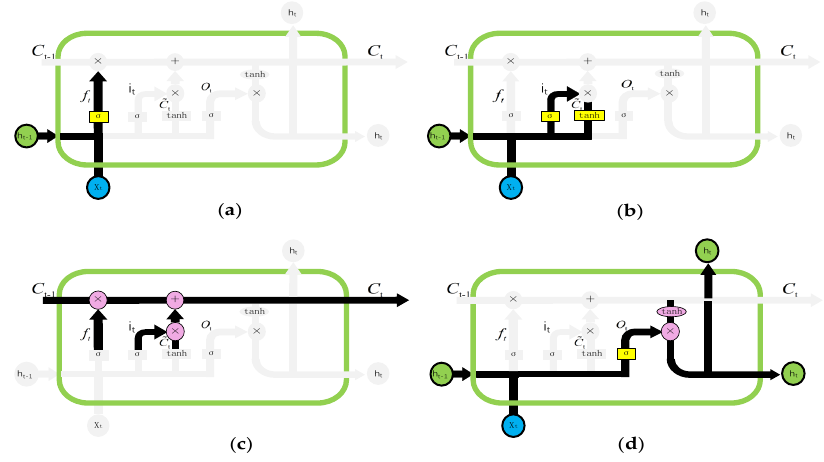
Figure 5. ( a ) Forget gate; ( b ) Input gate; ( c ) Merge process; ( d ) Output gate.